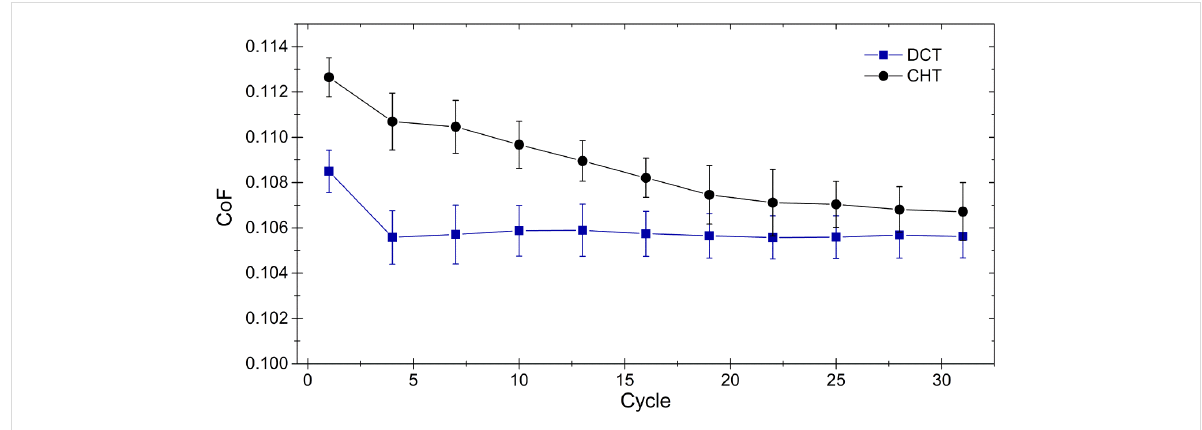
Figure 7: Evolution of the friction coefficient during the nanowear test.